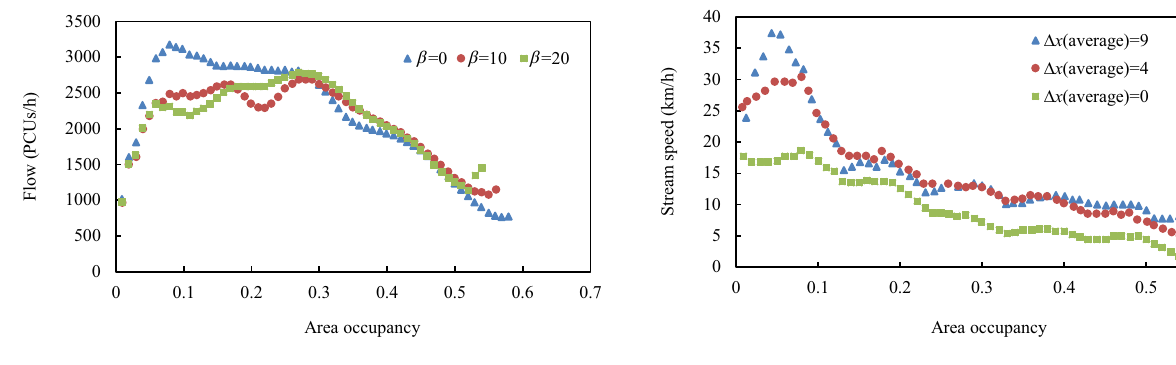
Fig. 11 Relationship between area occupancy and flow for different values of b and only car scenario using position preference based modified CA model